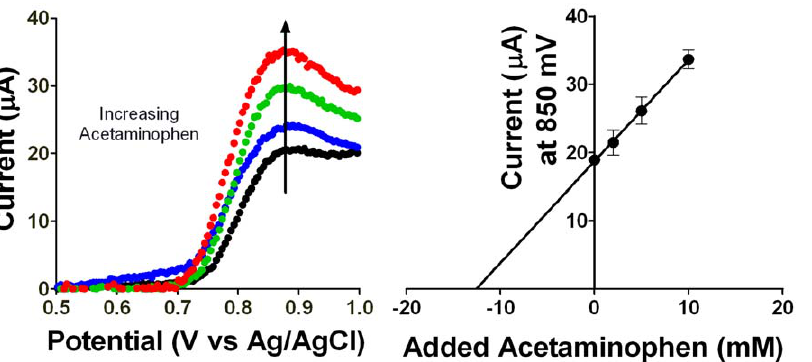
Figure 4. Analysis of the acetaminophen content of an over-the-counter painkiller using linear sweep voltammetry. An acetaminophen tablet was crushed and dissolved in sulfuric acid. Standards were added to three solutions, and one was left untouched. (Left) Linear sweep voltammetry performed with a gold-wire working electrode was used to measure the acetaminophen concentration by the method of standard additions. (Right) A linear extrapolation of the oxidation current observed at 850 mV was used to determine the initial acetaminophen concentration in a 250 mL solution containing one crushed tablet, which at 12.6 6 1.7 mM (472 6 63 mg per tablet) is close to the 500 mg per tablet reported by the manufacturer.